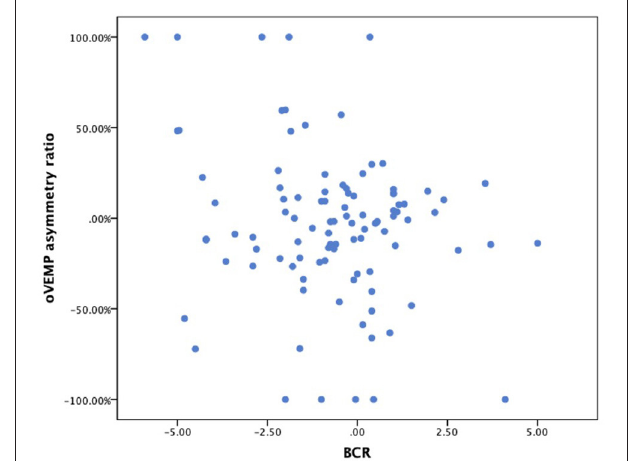
FIGURE 5 | Scatterplot of SVV (x-axis) vs. BCR (y-axis). Regression line: BCR = 0.27 + 0.52 × SVV. Spearman correlation: R 2 = 0.326; p < 0.001. SVV, subjective visual vertical; BCR, binocular cyclorotation.